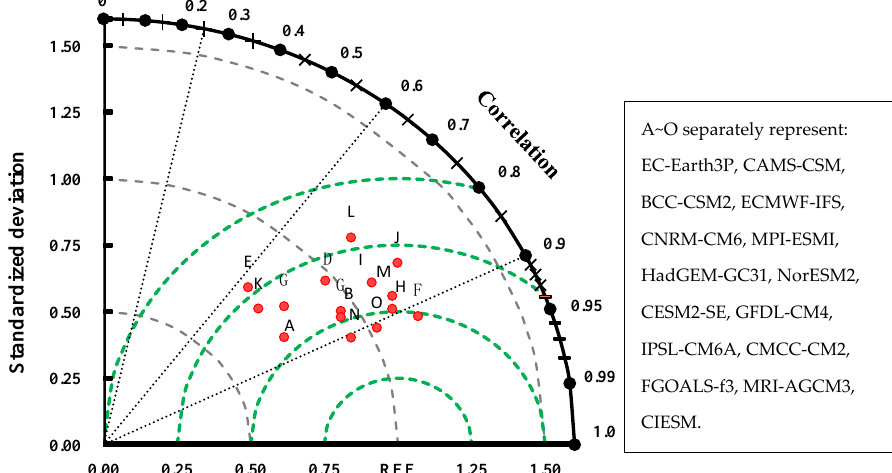
Figure 5. Taylor diagram for the temperature predicted by CMIP6 models and observations in the TP. The radial coordinate is the magnitude of the standard deviation (denoted by black arcs). The concentric green semi-circles denote root-mean-square difference values. The angular coordinate shows the correlation coefficient (denoted by dotted black lines).